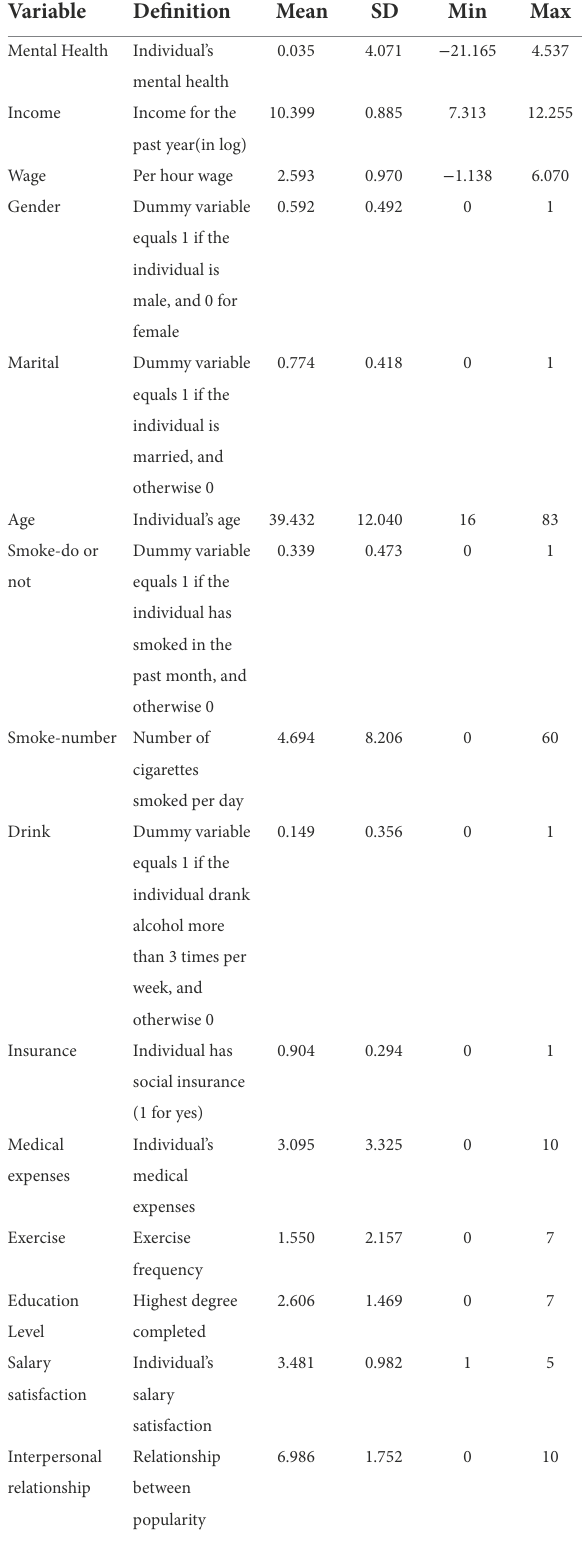
TABLE 1 Descriptive statistics of the key variables.